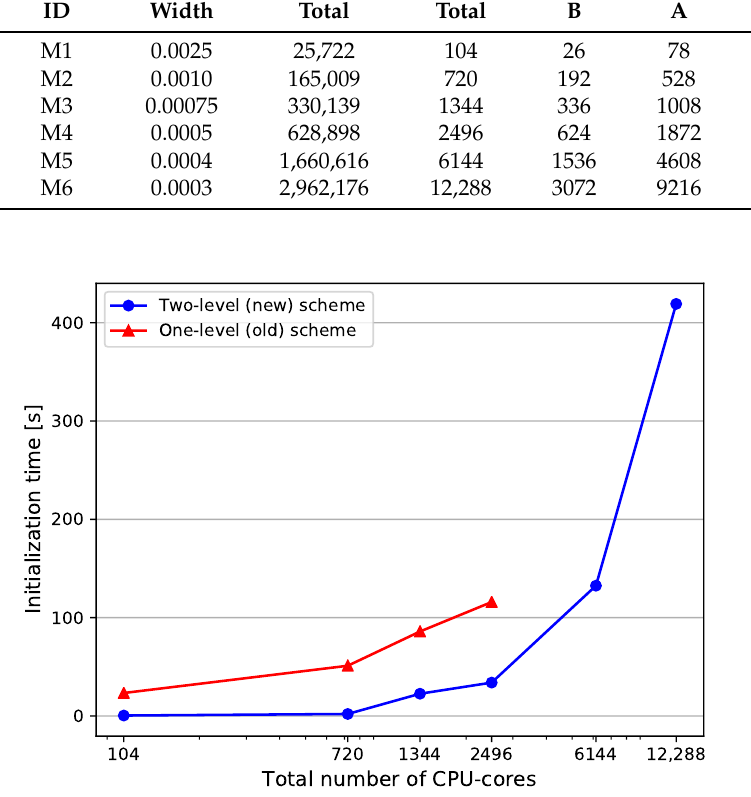
Figure 13. Weak scalability measurements: Total initialization time comparison between the two-level and the one-level schemes. The core distribution and the mesh information are given in Table